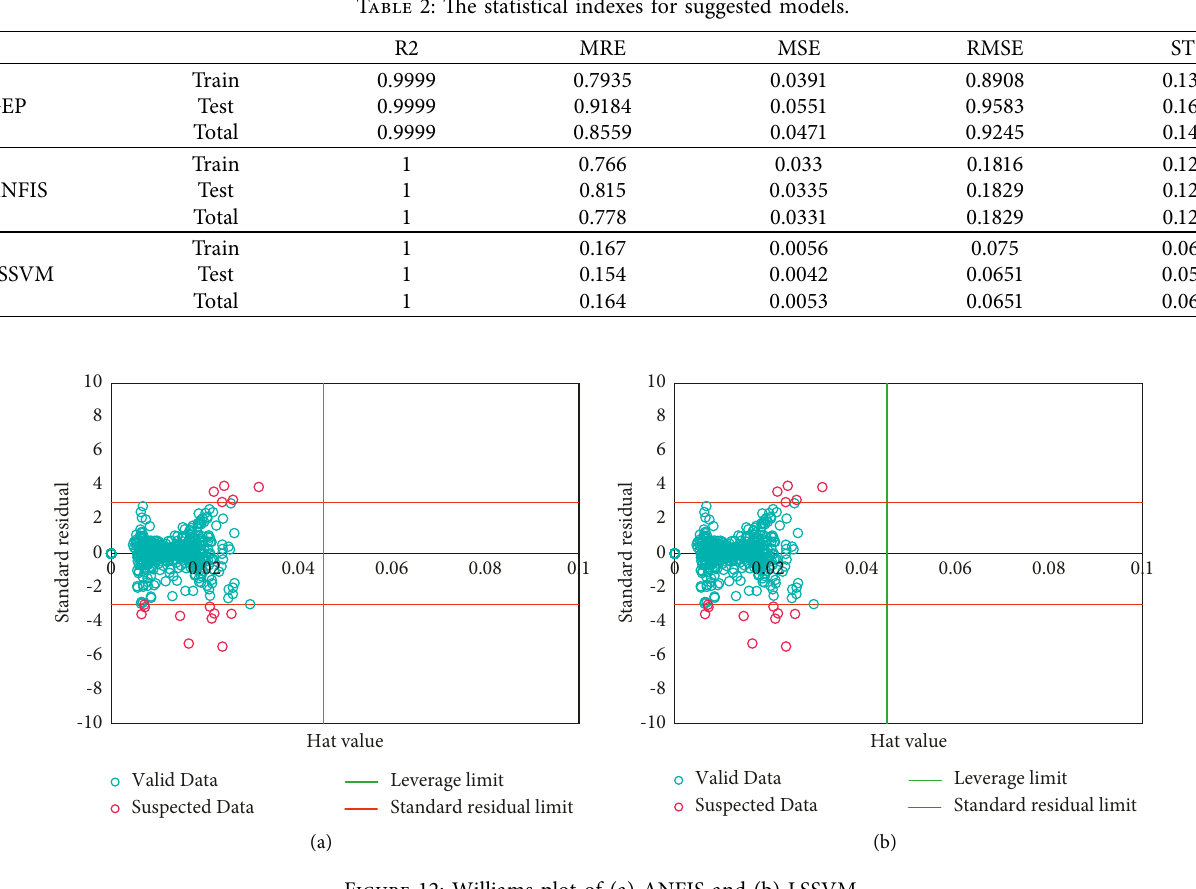
Figure 12: Williams plot of (a) ANFIS and (b)